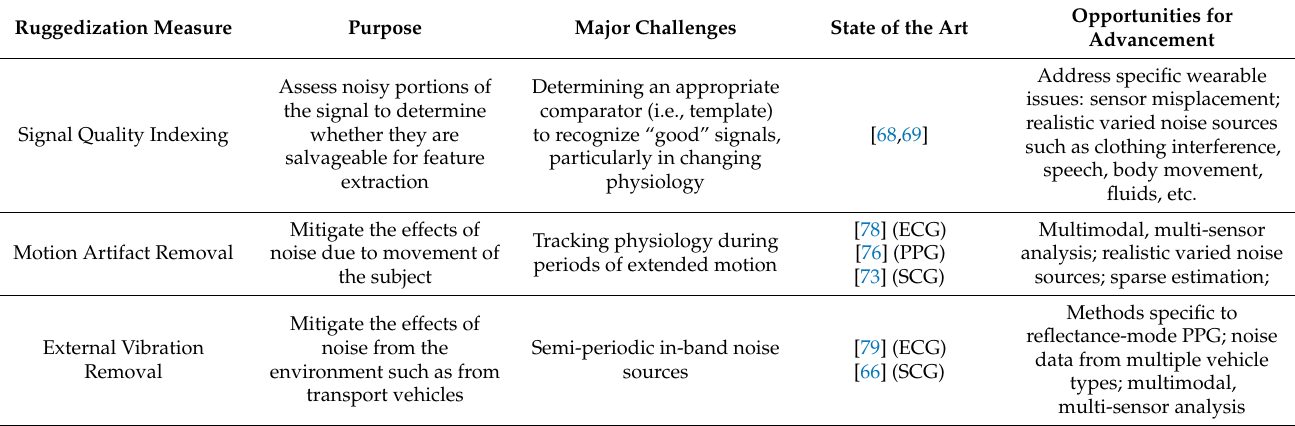
Table 1. Summary of Ruggedization